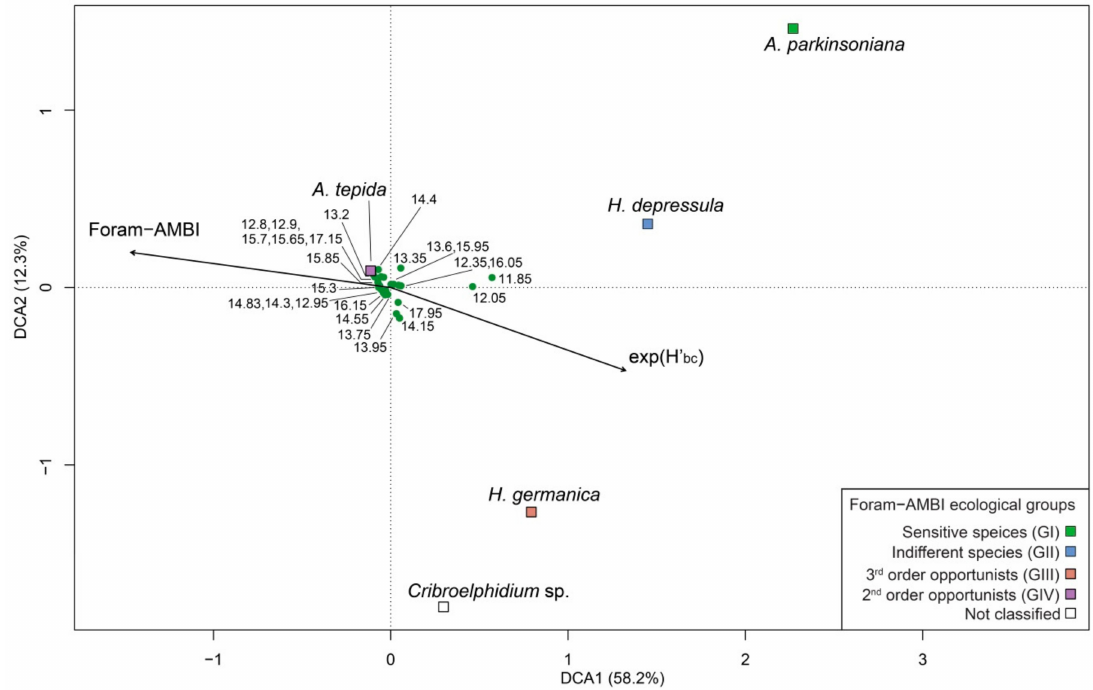
Figure 3. Detrended correspondence analysis (DCA) applied on the benthic foraminifer dataset of core 240 S5, showing samples and taxa colored in accordance with the Foram − AMBI ecological group. Total variance explained by each axis is reported. Exp(H’ bc ) and Foram − AMBI indices are plotted as additional